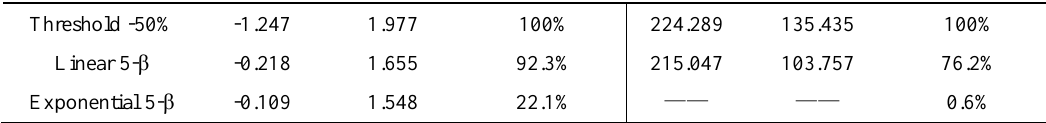
Table 1. Statistics of waveform retracking results